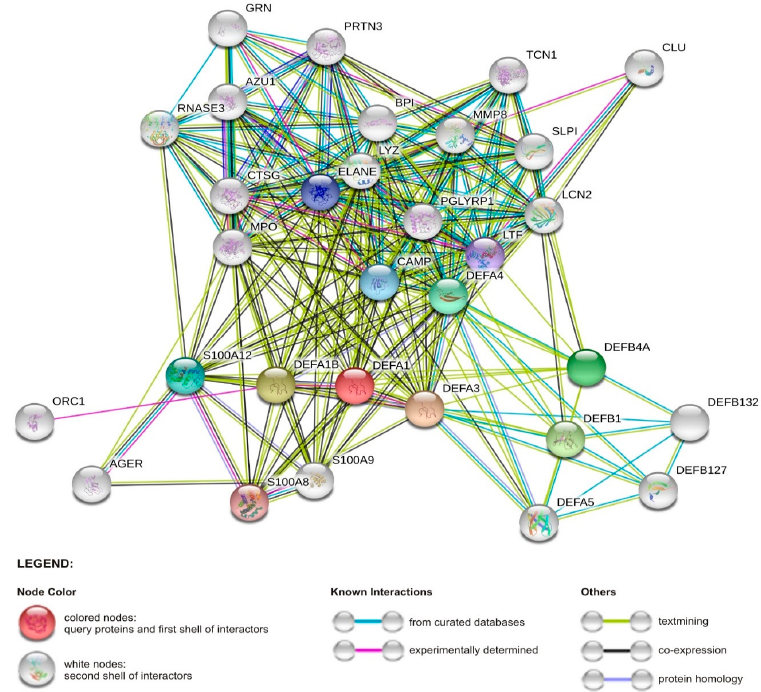
Figure 3. Network of interactions between α -defensin 1 gene ( DEFA-1 ) and other human proteins (the network was obtained from STRING v11 database) [87]. Represented proteins are central to antimicrobial and immunomodulatory activities. Abbreviations: AGER, advanced glycosylation end- product-specific receptor; BPI, bactericidal permeability increasing protein; CAMP, cathelicidin antimicrobial peptide; CLU, clusterin; CTSG, cathepsin; DEFA3, defensin alpha 3; DEFA4, defensin alpha 4; DEFA5, defensin alpha 5; DEFA1B, defensin alpha 1B; DEFB4A, defensin beta 4A; DEFB1, defensin beta 1; DEFB132, defensin beta 132; DEFB127, defensin beta 127; ELANE, neutrophil elastase; GRN, granulin precursor; LCN2, lipocalin 2; LTF, lactotransferrin; LYZ, lysozyme; MPO, myeloperoxidase; MMP8, matrix metallopeptidase 8; ORC1, origin recognition complex subunit 1; PGLYRP1, peptidoglycan recognition protein 1; PRTN3, proteinase 3; RNASE3, ribonuclease A family member 3; SLP I, secretory leukocyte peptidase inhibitor; S100A8, S100 calcium binding protein A8; S100A9, S100 calcium binding protein A9; S100A12, S100 calcium binding protein A12; TCN1, transcobalamin 1. Indeed, a link between HDPs and multiple autoinflammatory diseases such as skin disease (atopic dermatitis, psoriasis, rosacea) or microbiota-related ones, e.g., IBD (Crohn’s disease, colitis ulcerosa), acne vulgaris, and periodontitis, has been established by several studies (see below). An enhancement of Th17 response by HDPs may serve as an example. Briefly, HDPs efficiently attract Th17 (T helper 17 cells), which in turn secrete pro-inflammatory cytokines, IL-17A, IL-17F, IL-21, and IL-22, responsible for mounting mucosal defense against pathogenic microbes in the respiratory or intestinal tract. For instance, IL-17A and IL-22 work synergistically to induce certain β -defensins hBD-1, hBD-3, and hBD-4 in both human and primary mouse gastric epithelial cells (GEC) and